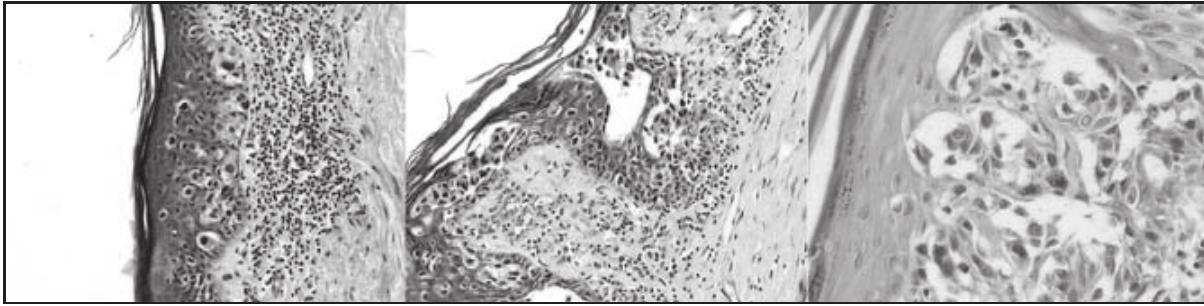
Figura 2 – Retalho de pele apresentando múltiplas lesões melanocíticas em área de cicatriz de queixo